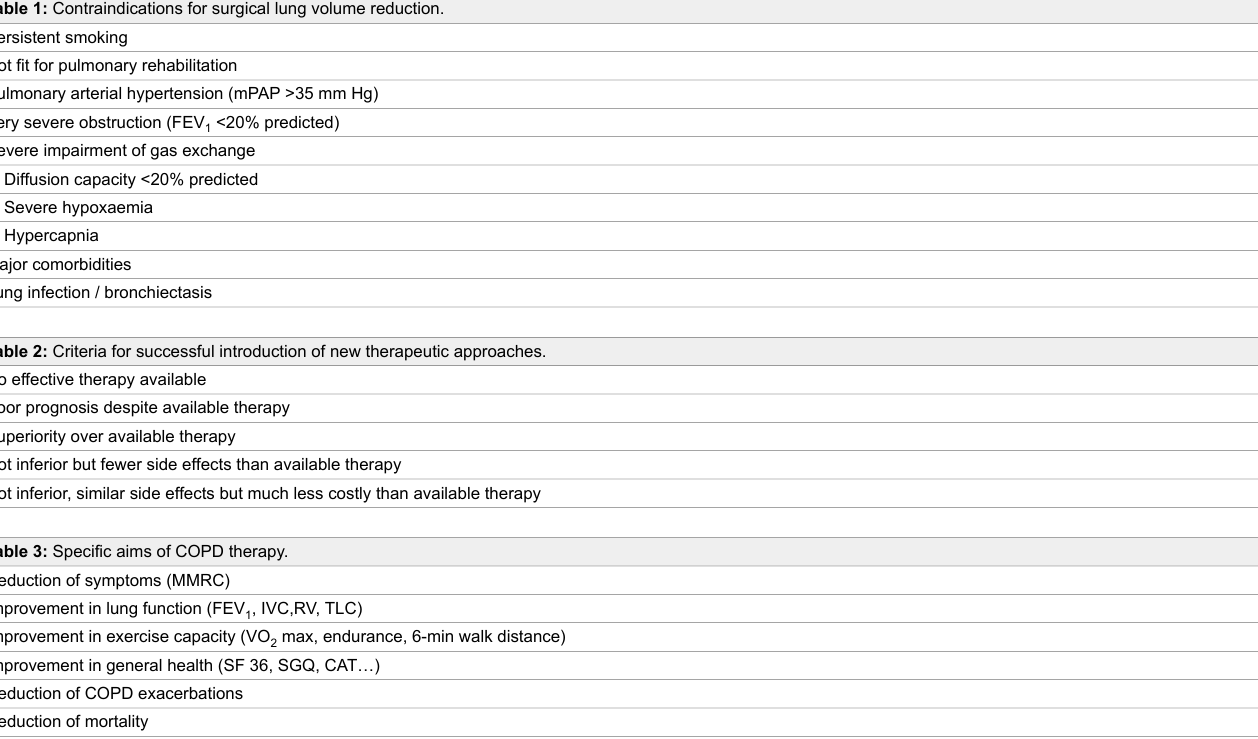
Table 1: Contraindications for surgical lung volume reduction.